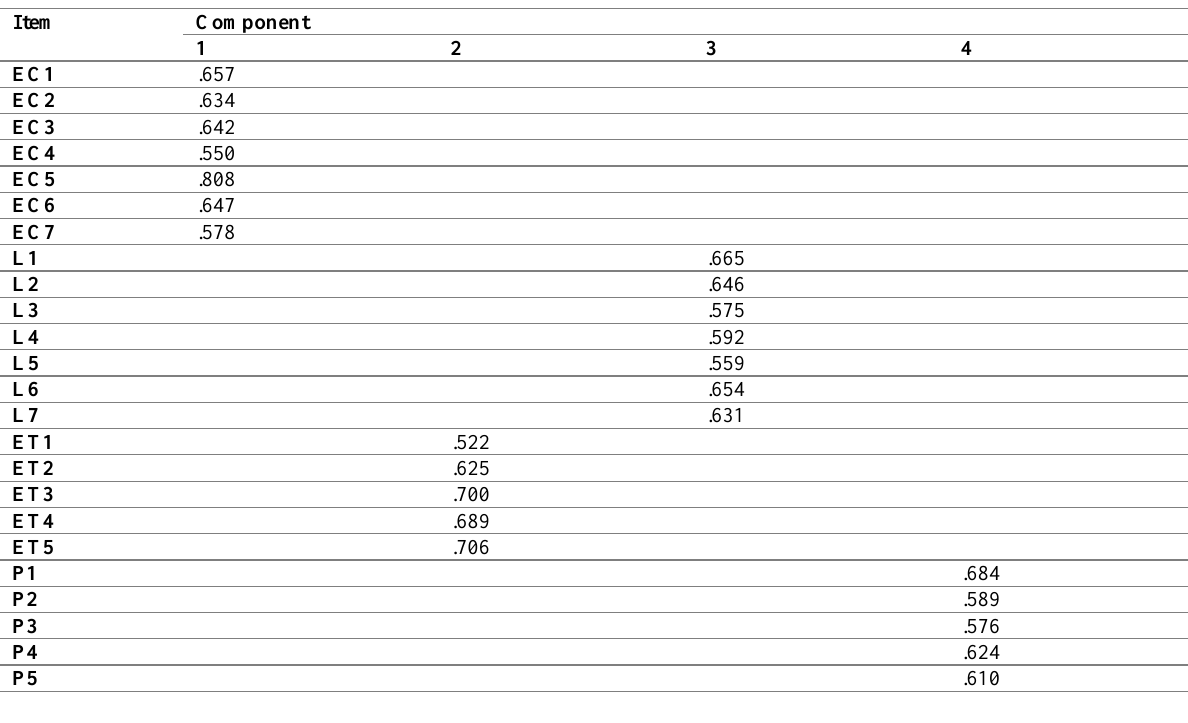
Table 7: Exploratory Factor Loadings of the Corporate Social Responsibility (n=188)